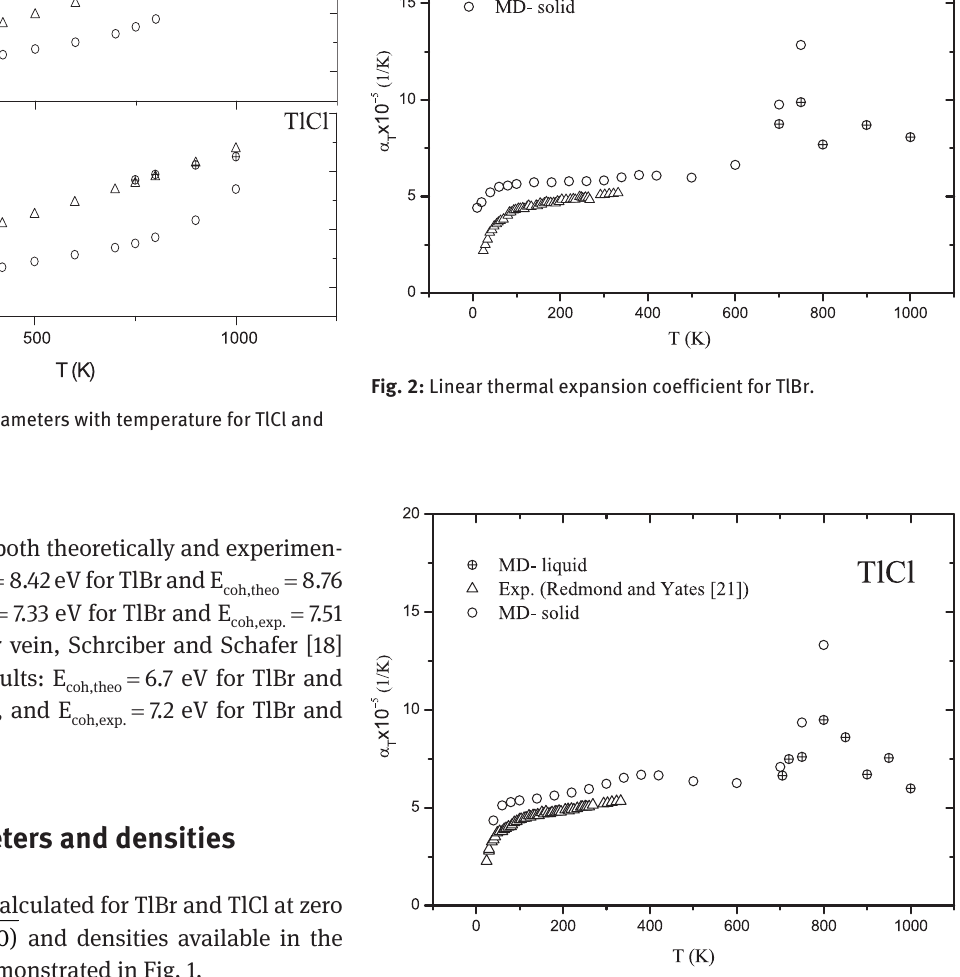
Fig. 3: Linear thermal expansion coefficient for